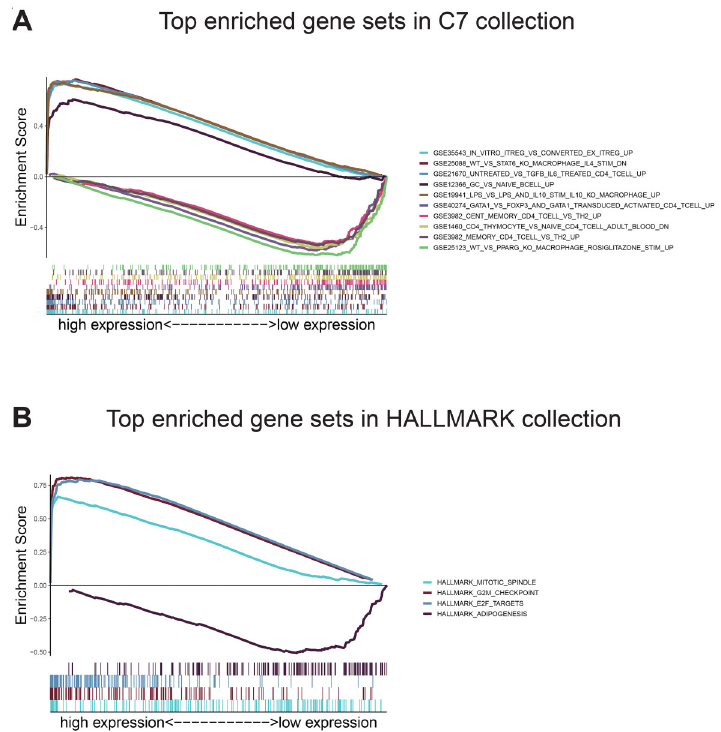
Figure 7. Gene Set Enrichment Analysis. A , Top ten enriched gene sets annotated by the C7 collection between the high- and low-risk groups in the CBTTC cohort. B , Enriched gene sets annotated by the HALLMARK collection between the high- and low-risk groups in the CBTTC cohort. Each line represents one speci fi c gene set with unique color. Up-regulated genes are located at the left, approaching the origin of the coordinates, and the down-regulated are located at the right of the x-axis. Only gene sets with family-wise error rate (FWER) P values o 0.05 were considered signi fi